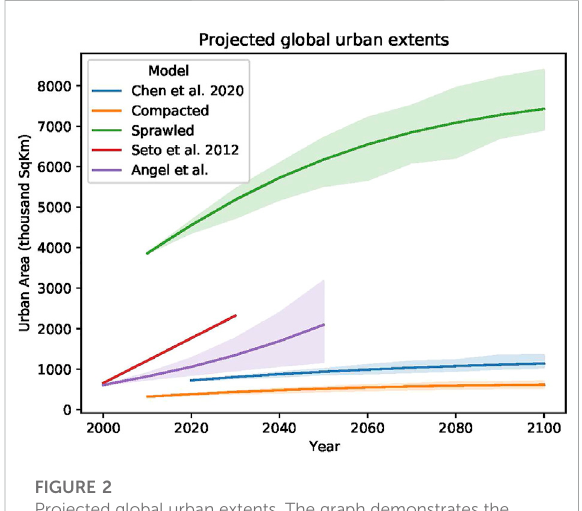
FIGURE 2 Projected global urban extents. The graph demonstrates the difference in urban land use amongst competing global urban growth models. The intent of the study was not to generate one modelsimulation forurbangrowth,buttocreatetwomodels with very different outcomes that would include the results of other models. In this way, our study provides a range of potential population exposure to heatwaves that occur across the landscape. Our model simulations are green (sprawled) and orange (compact). The other global urban model growth results in the chart are from Seto et al. (2012), Angel et al. (2010) and Chen et al. (2020) also are included.